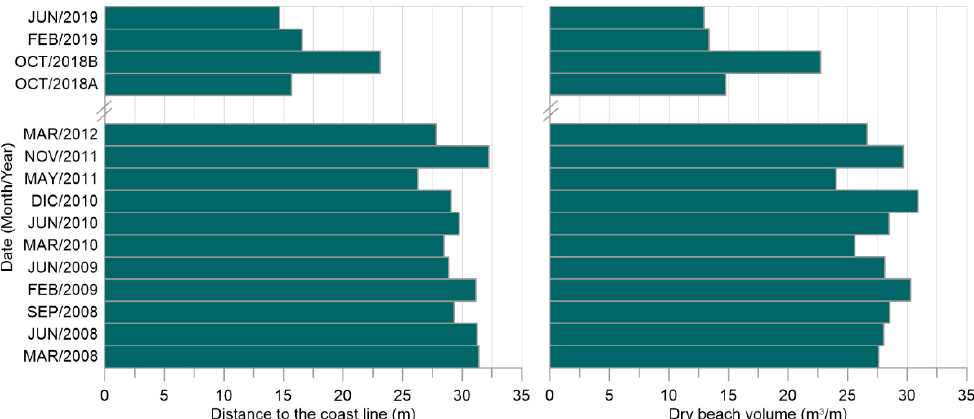
Figure 11. Coastline width retreat and dry beach volumes from 2008 to 2019, for a beach at Puerto Morelos.